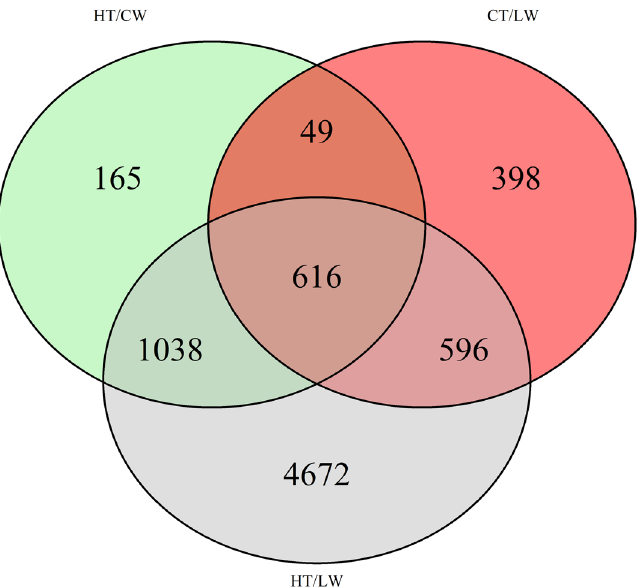
Figure 2. Venn diagram of the numbers of differentially expressed transcripts compared to control treatments